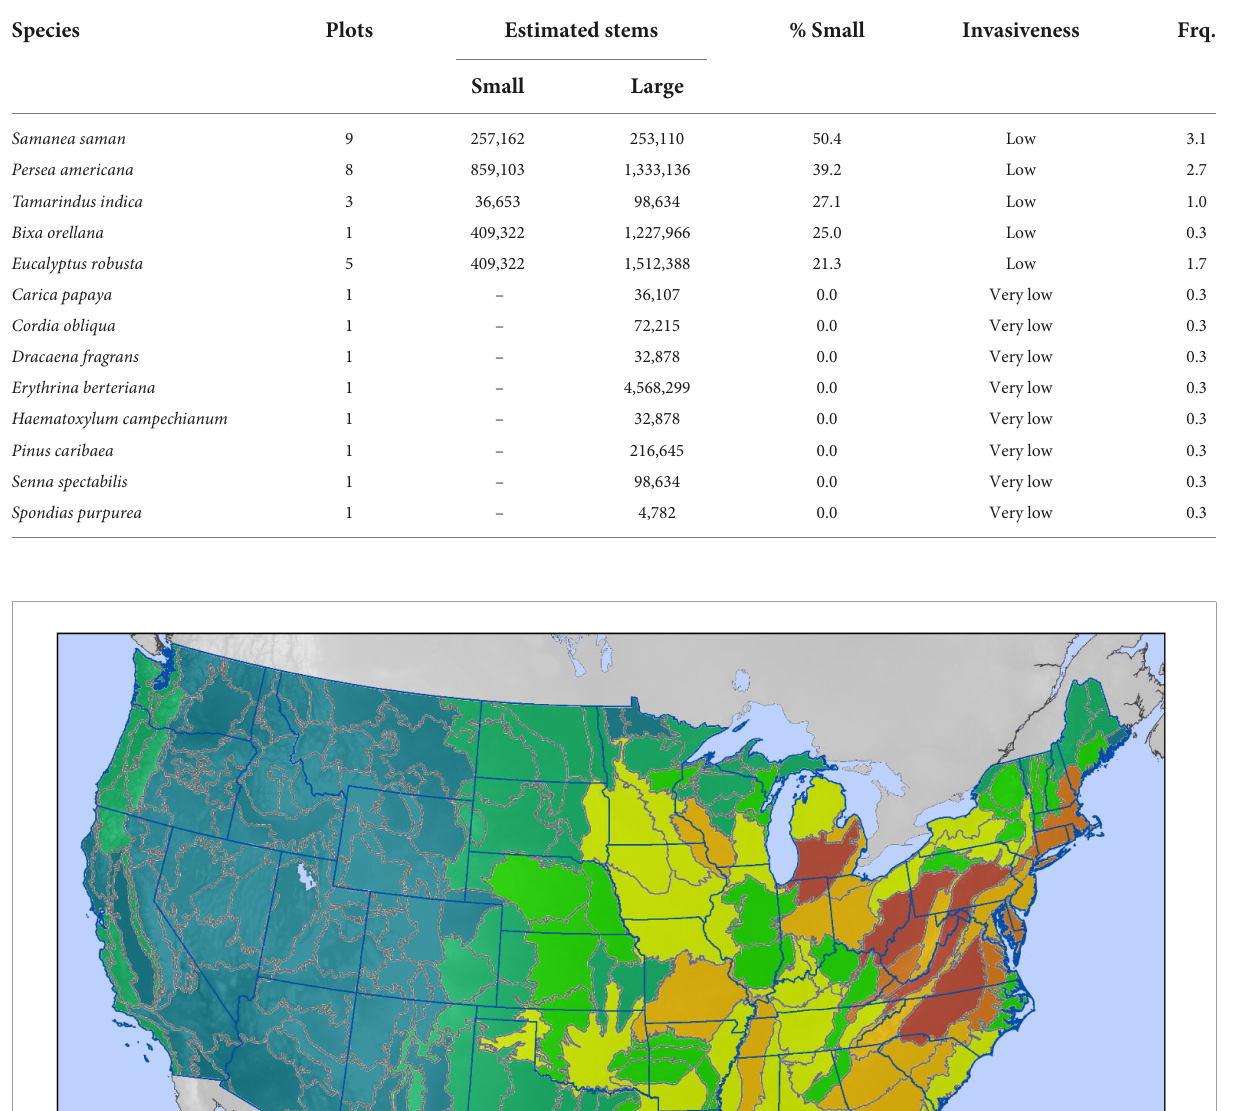
Frontiers in Forests and Global